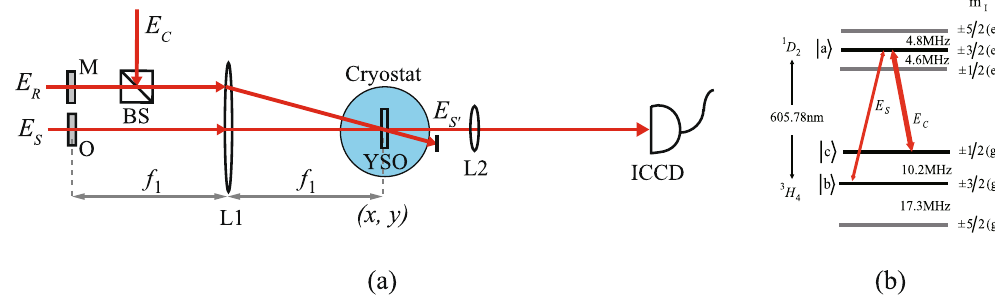
Figure 1. ( a ) The schematic diagram of experimental setup to observe the subwavelength interference of a double-slit through EIT-based light pulse storage and retrieval. Here E S , E C , E R and E S ′ are the input signal, the coupling, the readout and the retrieved output signal beams, respectively. O represents the double-slit, M is the π -phase-shifted n -slit mask, BS is the beam splitter, L1 and L2 are two lenses, ( x , y ) is the transverse coordinates in the rear focal plane of lens L1, ICCD is an intensified charge-coupled device camera. ( b ) The hyperfine energy-level structure of the transition 1 D 2 ↔ 3 H 4 of Pr 3 + ion in YSO crystal, where one upper level | a 〉 and two lower levels | b 〉 and | c 〉 form the typical Λ -type three-level configuration employed in the